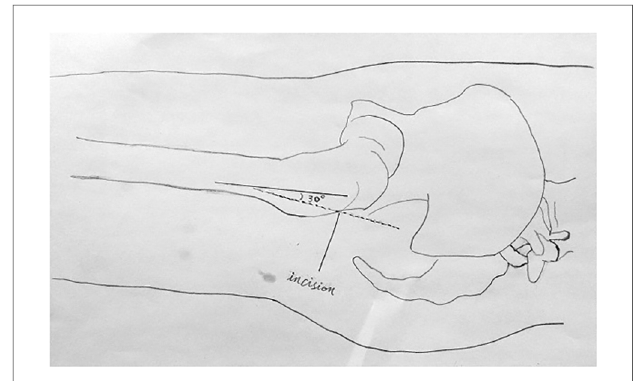
FIGURE 1 The modi fi ed hip incision. The modi fi ed hip incision, 5 cm below the apex of the greater trochanter, was made at a 30 degree angle to the femur, and the oblique incision was made upward about 8 to 12 cm.